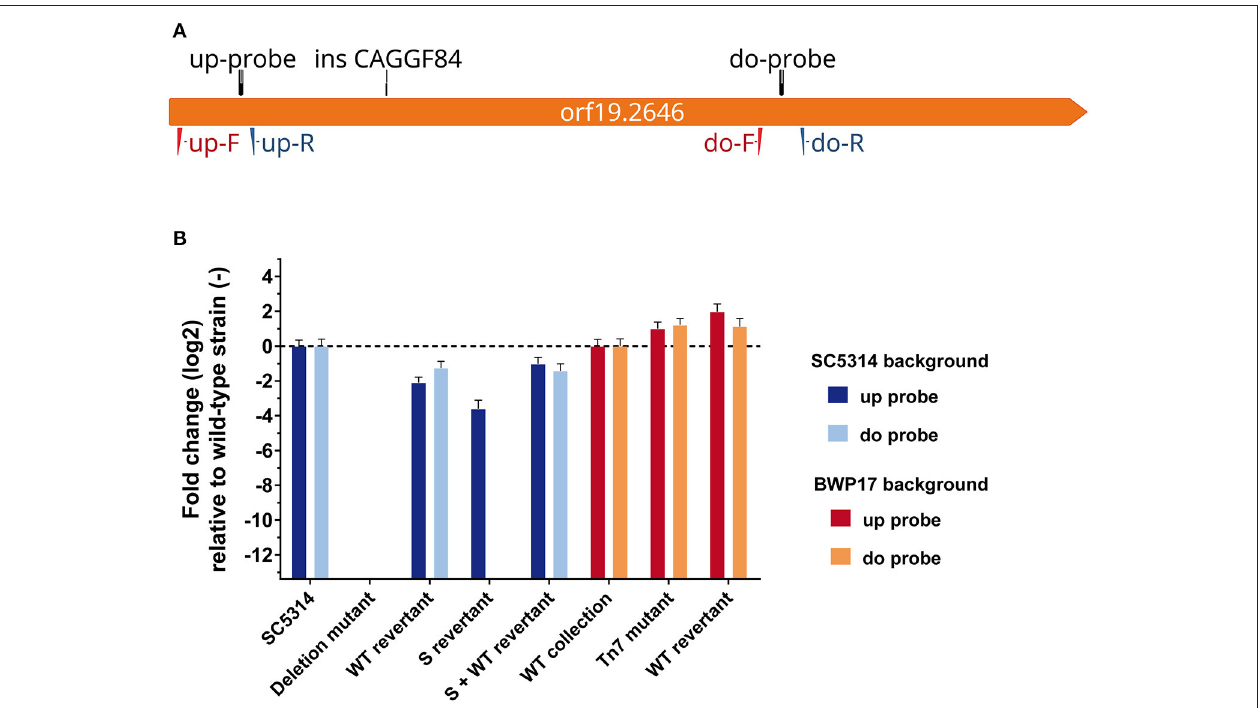
FIGURE 2 | mRNA level of Tn7 putative upstream and downstream transcript. (A) Map of orf19.2646 with the position of the upstream (up-) and downstream (do-) primers and up- and do-TaqMan TM probes. (B) RT-qPCR relative quantification of upstream and downstream transcripts. Results are expressed relative to the quantity measured for the isogenic wild-type strains. Each bar-plot corresponds to the mean of two biological samples measured in